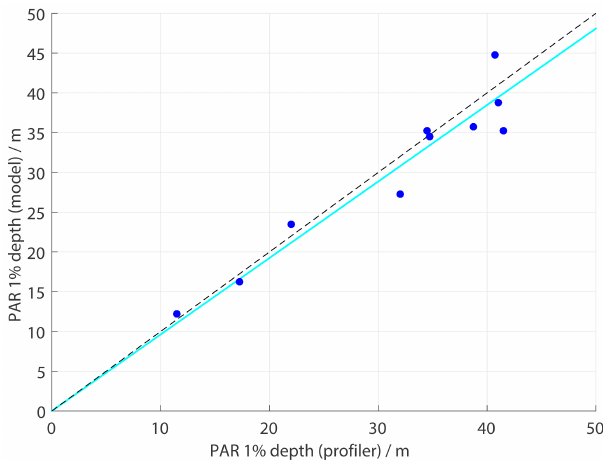
Figure 7. Comparison between measured and modeled 1% PAR depths. The cyan line represents the best linear correlation between the two parameters ( R 2 = 0 . 92) and the dashed black line the 1:1